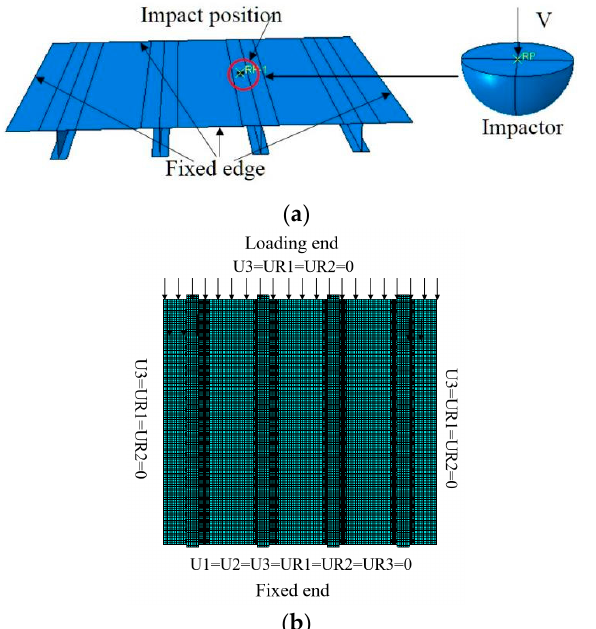
Figure 5. Finite element model and boundary condition. ( a ) Impact simulation; ( b ) Compres- sion simulation.